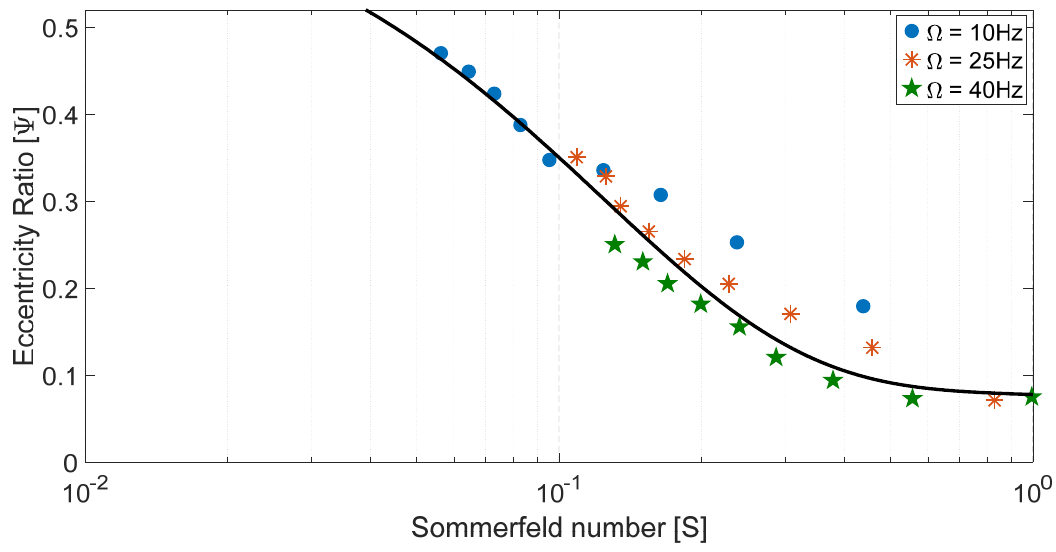
Figure 14. Bearing eccentricity ratio vs. Sommerfeld number for TPJBs.